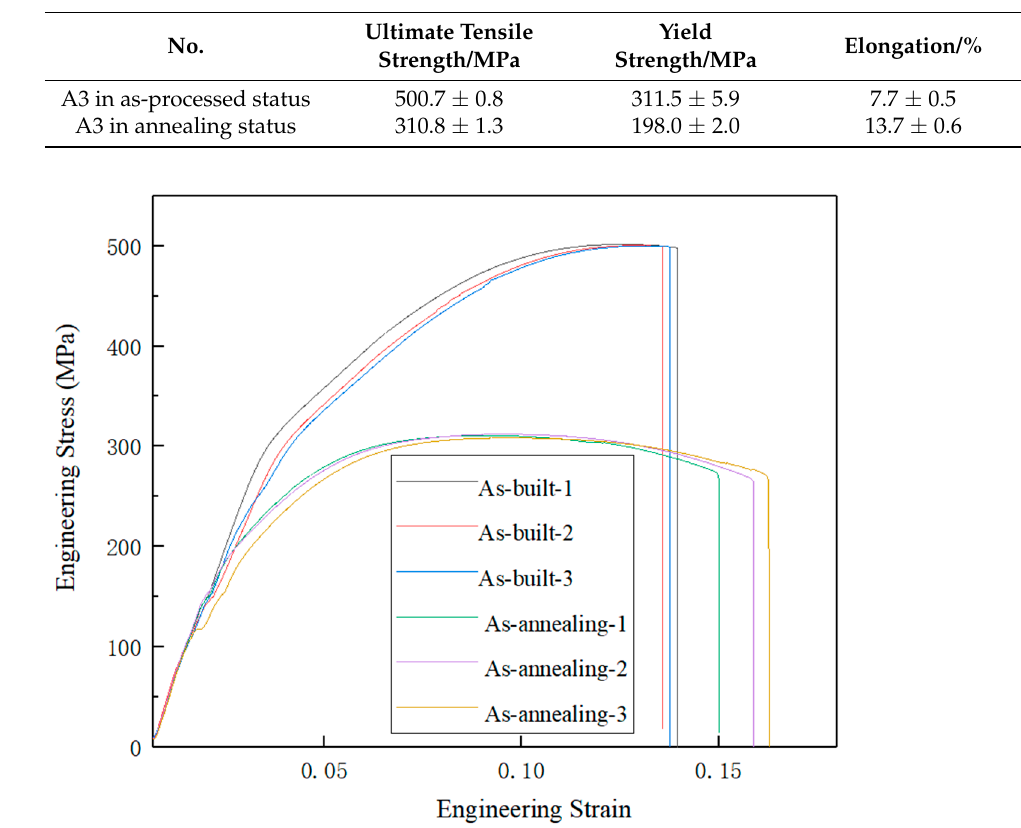
Figure 14. Engineering stress–strain curves of the AlSi10Mg alloys in the as ‐ built state and after annealing treatment at 275 °C for 2